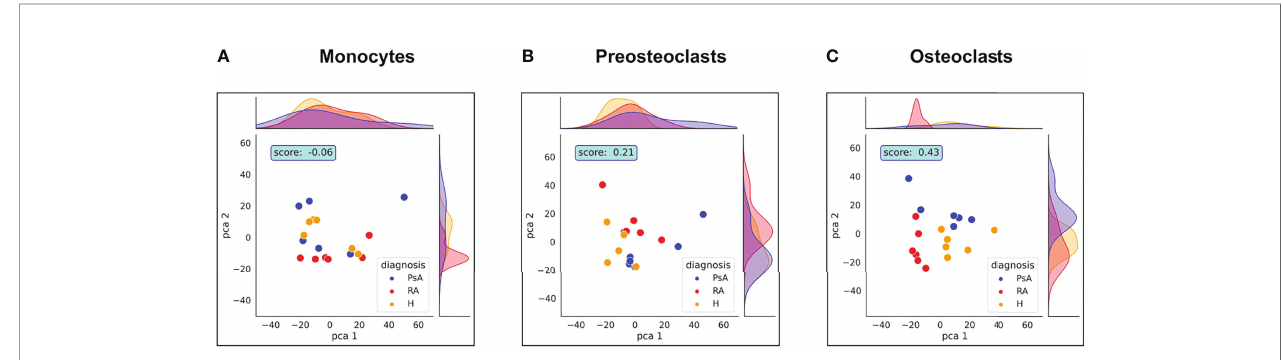
FIGURE 6 | Healthy, RA or PsA samples vary mostly in osteoclast state. PCA analysis representing the differences between healthy, RA or PsA samples in (A) monocytes, (B) preosteoclasts and (C)